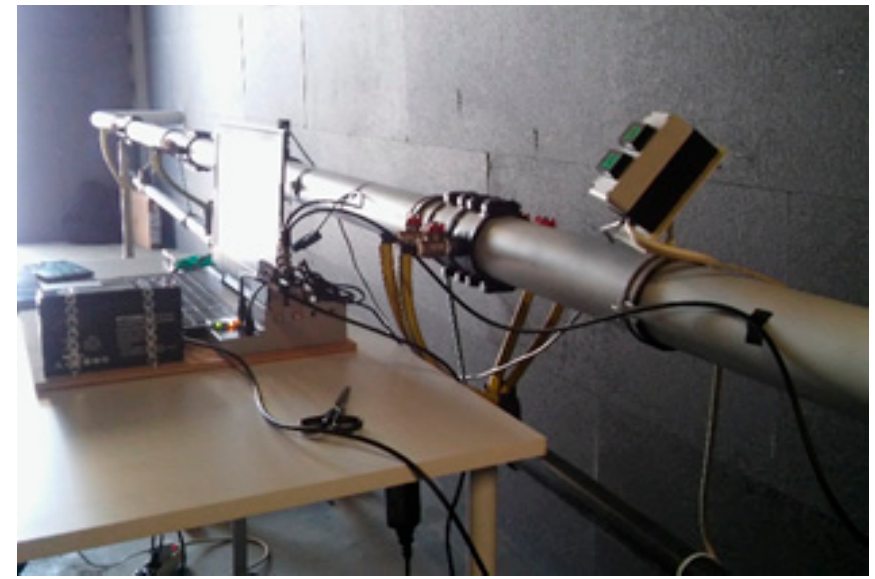
Figure 3. The experimental setup.